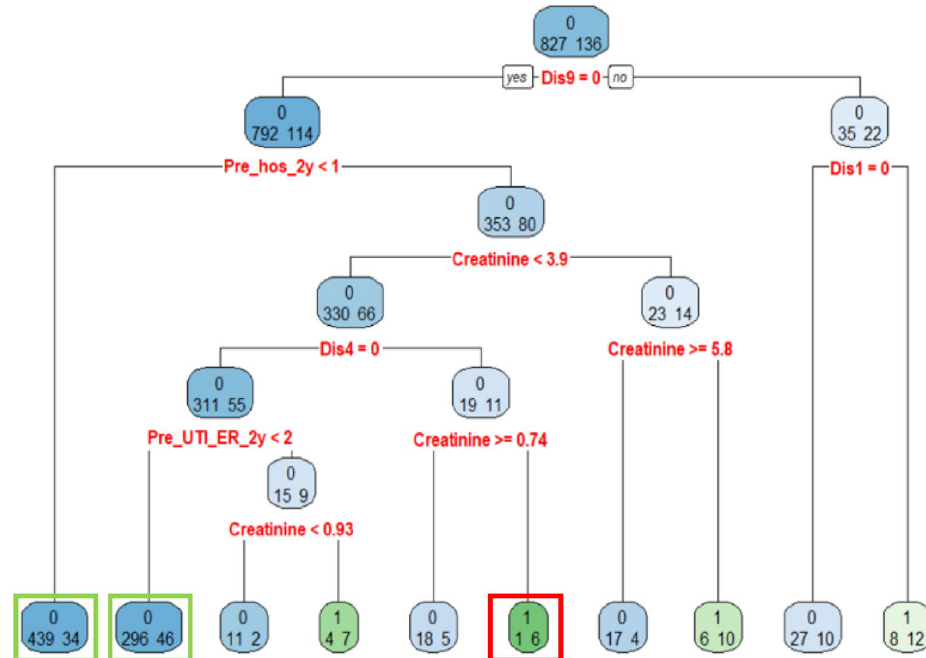
Figure 2. The decision rules of the DT analysis for development of RUTI in the clinical visit. (sample size = 963). The 2 green boxes and 1 red box indicate the nodes of the decision rules with an accuracy rate higher than 0.85 and 0.70 for non RUTI and RUTI classification,